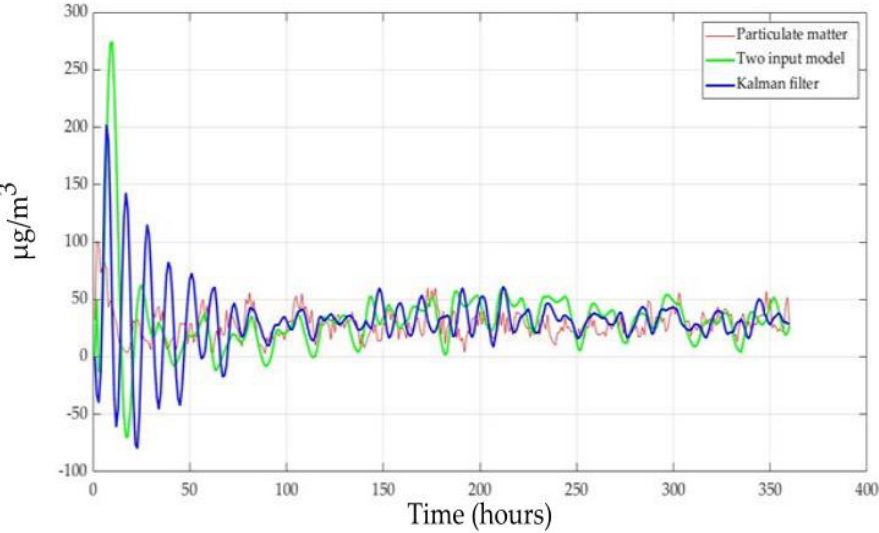
Figure 10. Kalman filter prediction vs. model prediction.